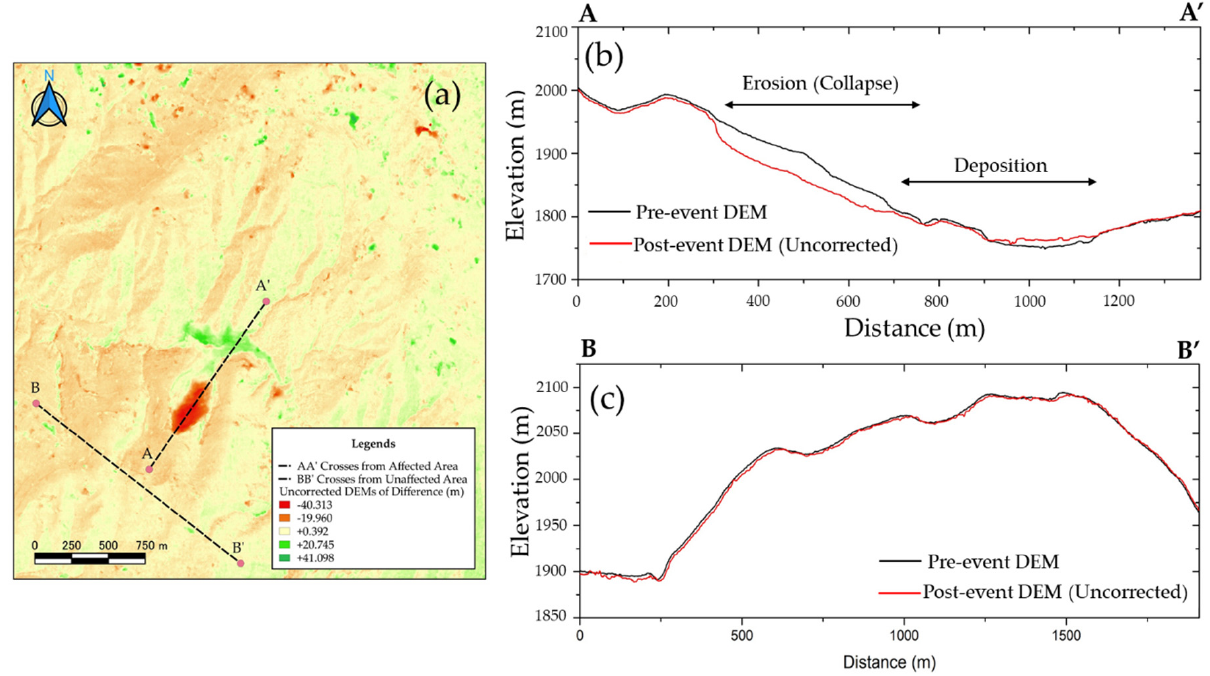
Figure 13. ( a ) Uncorrected DoD with the A-A’ and B-B’ cross-section lines. ( b ) Profile cross-section line (A-A’) passing through the affected area. ( c ) Profile cross-section line (B-B’) passing through the unaffected